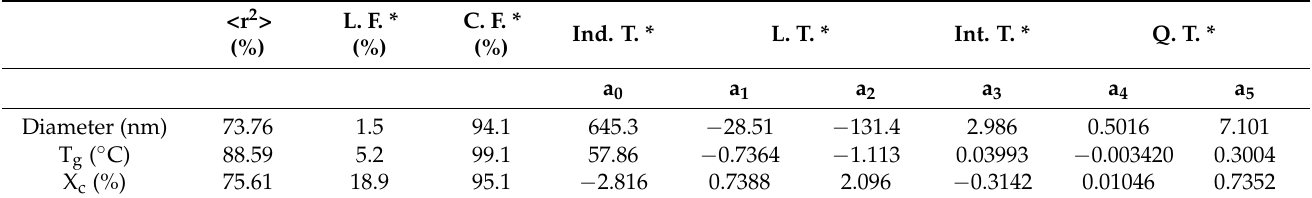
Table 3. Statistical parameters and coefficients of the polynomial equations from the